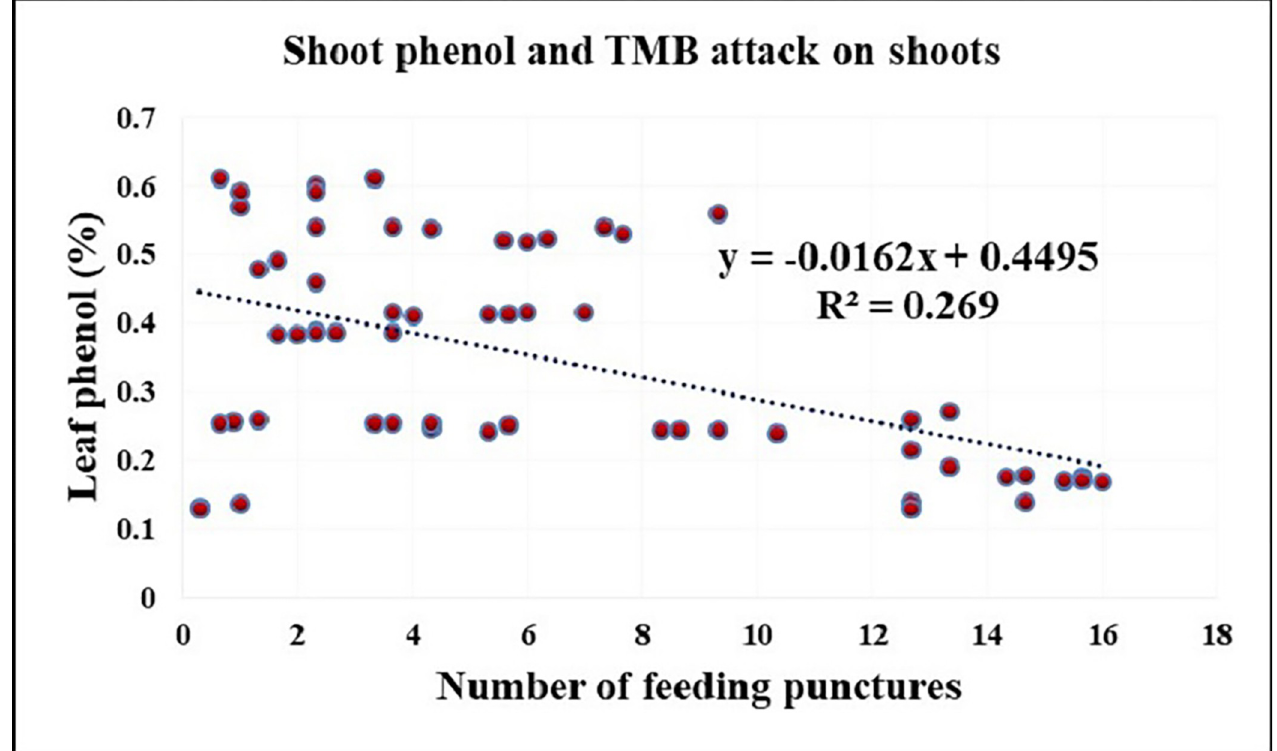
Fig 4. Correlation between shoot phenol (%) and number of feeding lesion on shoot.